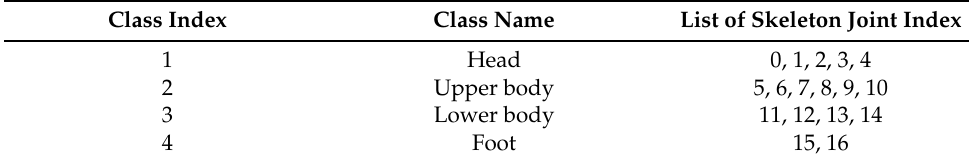
Table 1. The class of attention mask corresponding to skeleton join index.